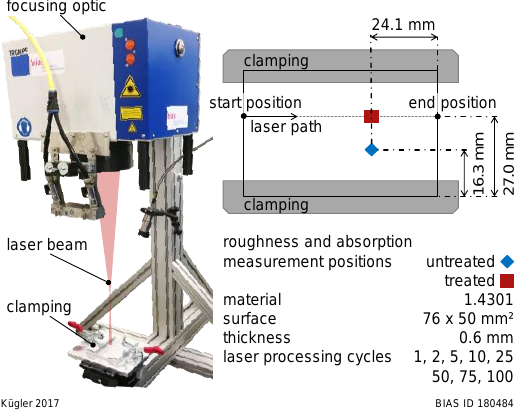
Figure 1. The laser beam processing set-up ( left ) and measuring points sketch ( right ).